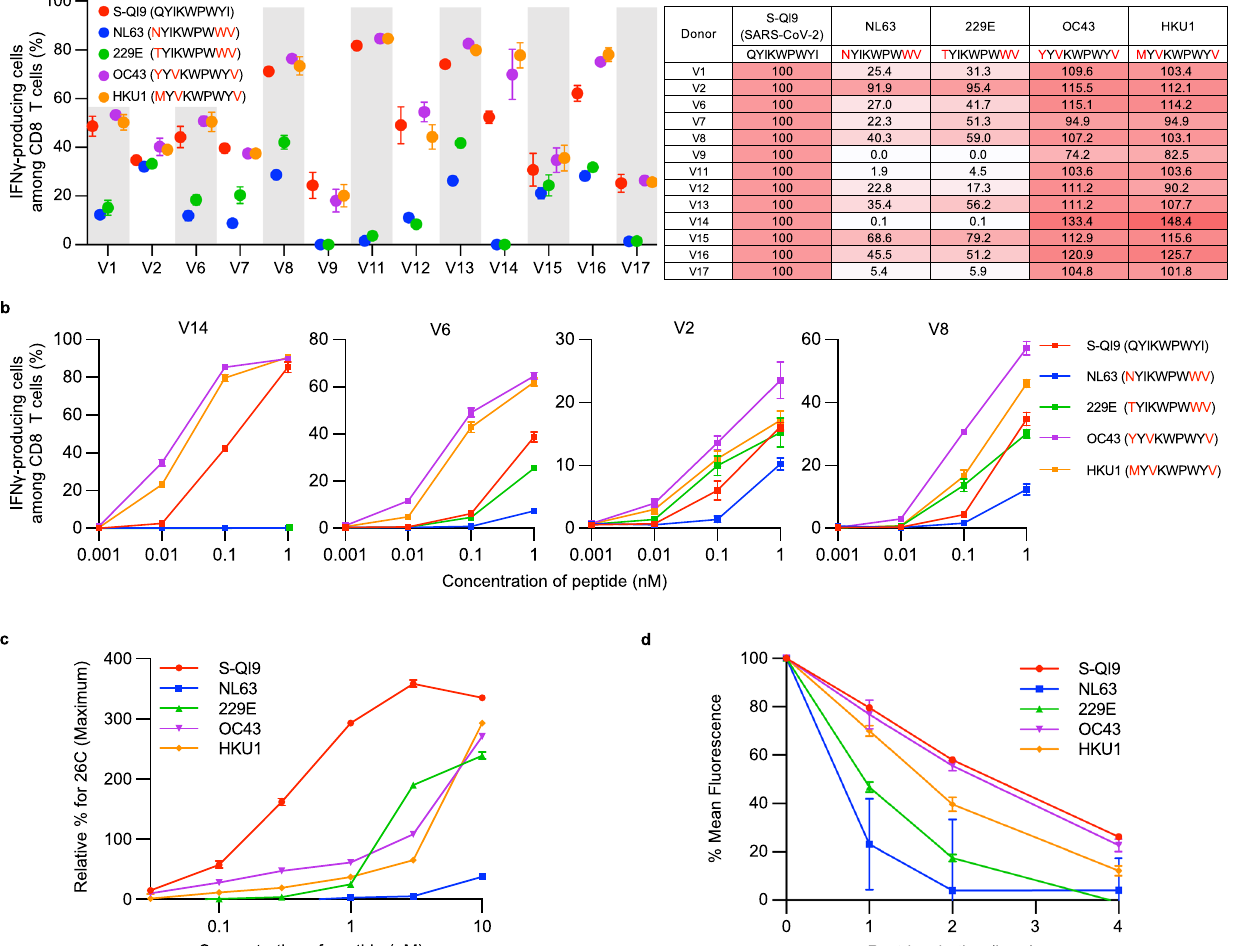
Fig. 7 | Recognition of S-QI9 variants peptides derived from seasonal human coronaviruses by S-QI9-speci fi c T cells and binding af fi nities and stabilities of S-QI9 variant peptides for HLA-A*24:02. a Left: Recognition of S-QI9 and S-QI9 mutantpeptidesderivedfrom4seasonalhumancoronaviruses(NL63,229E,OC43, and HKU1) by S-QI9-speci fi c CD8 + T cells established from 13 HLA-A*24:02 + indivi- duals who were vaccinated with 2 doses of the mRNA vaccine. Responses of bulk T cells to C1R-A*2402 cells pre-pulsed with 1nM of each peptide were analyzed by ICSassays.Right:ThefrequenciesofCD8 + Tcellsspeci fi cforS-QI9variantpeptides relative to CD8 + T cells speci fi c for S-QI9 peptides. b Recognition of S-QI9 and 4 S-QI9 variant peptides derived from seasonal human coronaviruses by S-QI9- speci fi c CD8 + T cells established from 4 representative HLA-A*24:02 + vaccinated individuals. T cell responses were analyzed by ICS assays after exposure to